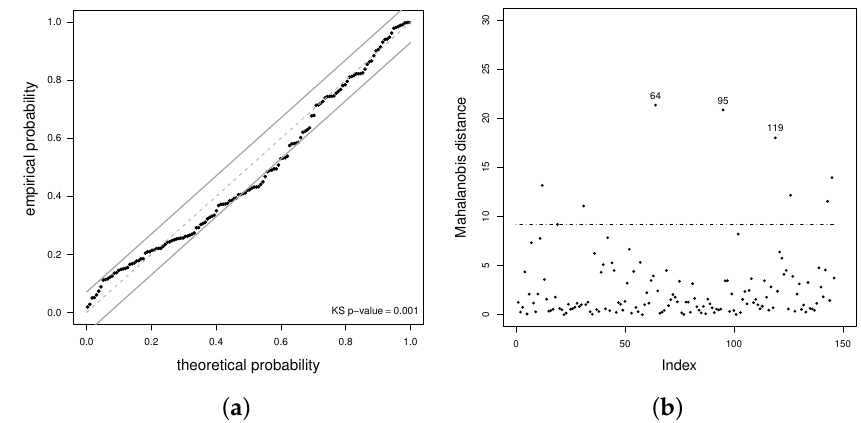
Figure 4. PP plot with KS acceptance bands at 5% ( a ) and index plot for transformed Mahalanobis distance (MD) ( b ) using the BS model with Chilean PM data from the Pudahuel monitoring station, in Santiago, Chile, during 2015.